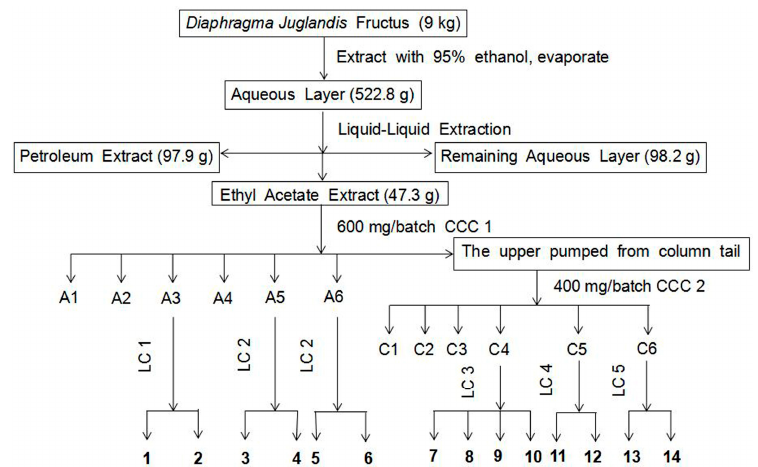
Figure 4. Overall work flow for isolation using HSCCC and purification by pre-HPLC of compounds from Diaphragma juglandis fructus. CCC 1: petroleum ether-ethyl acetate-methanol-water (1:9:1:9, v / v / v / v ); CCC 2: petroleum ether-ethyl acetate-methanol-water (1:2:1:2, v / v / v / v ); LC 1: 30% methanol